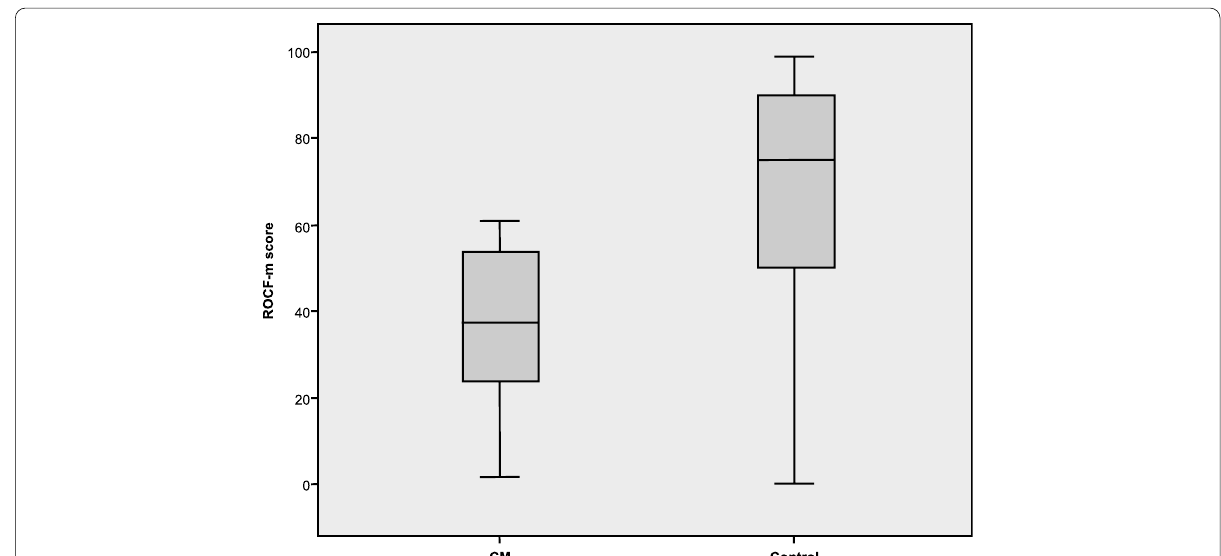
Fig. 5 Results of the ROCF memory task in the CM group and the control group without mood changes at baseline. ROCF‑m: Rey‑Osterrieth Complex Figure test, memory